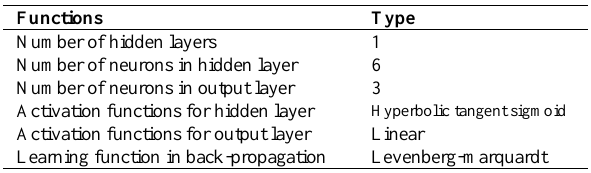
Table 2. Specifications of FFNN used to distinguish atmospheric situation class.